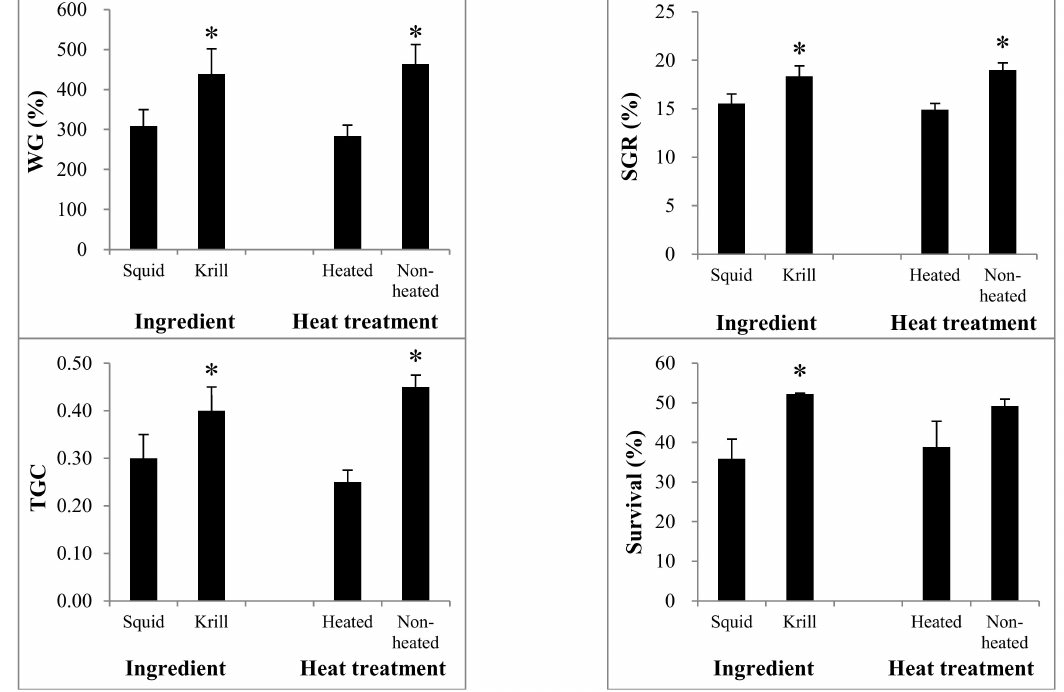
Figure 4. Means of WG (g, upper-left ), SGR (%, upper-right ), TGC ( lower-left ), and survival (%, lower-right ) of juvenile Pacific bluefin tuna after rearing period for the main effects of ingredient and heat treatment. Data was expressed as means ± SE. WG, weight gain; SGR, specific growth rate; TGC, thermal growth coefficient. The asterisks indicate significant differences by two-way ANOVA analysis ( p <